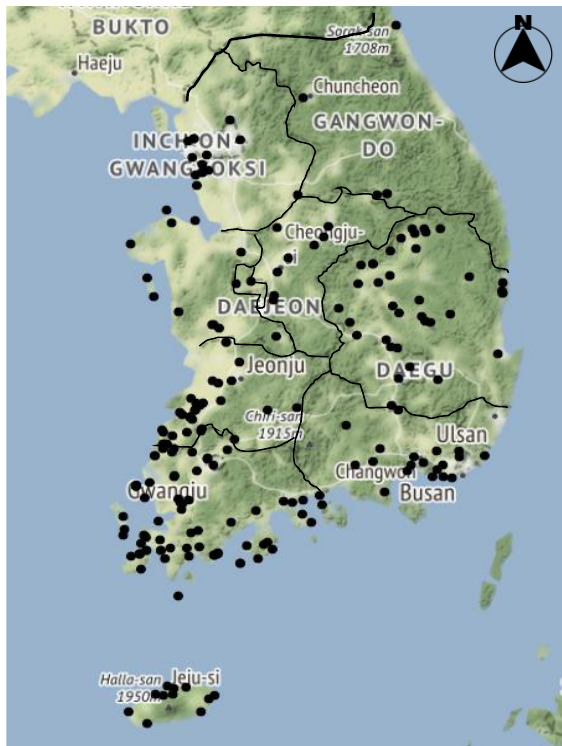
Figure 3. Spatial distribution of 215 power plants (black dots) on a national map.